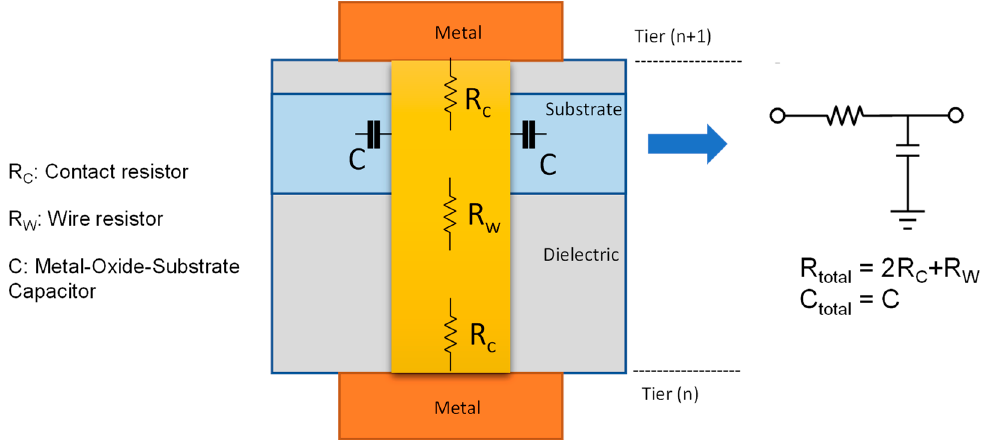
Figure 7. MIV model with equivalent resistance and capacitor.